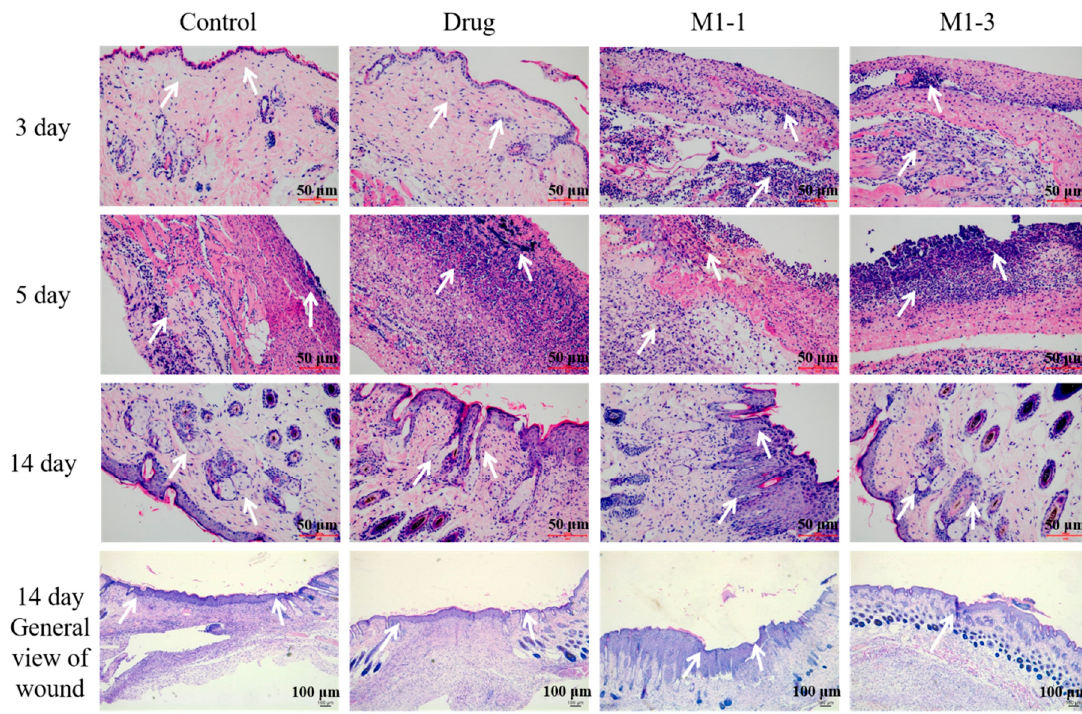
Figure 7. H&E staining of skin tissues at days 3, 5, and 14.